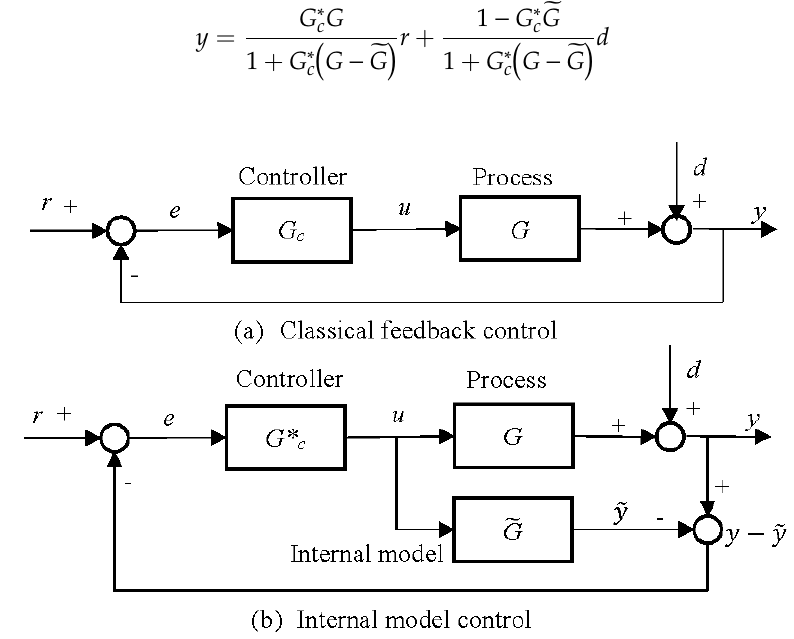
Figure 5. Classical feedback control and internal model control.